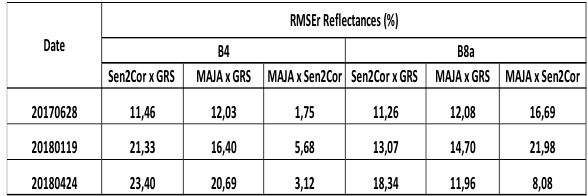
Table 1 - RMSEr’s L1 region reflectances referenced by mean reflectance GRS and Sen2Cor